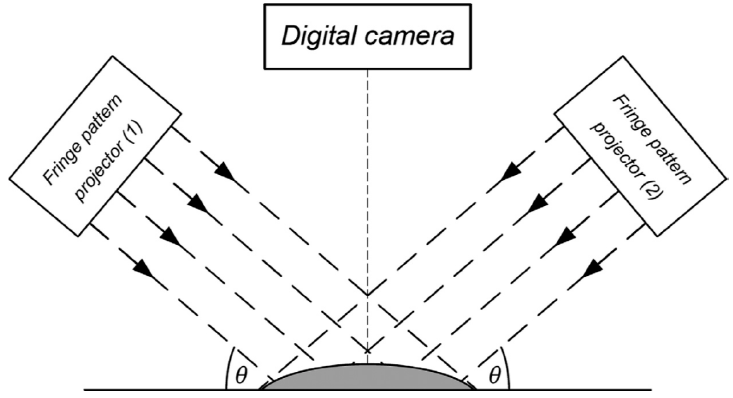
Figure 11. Eye surface profiler using two symmetrical projectors [80].